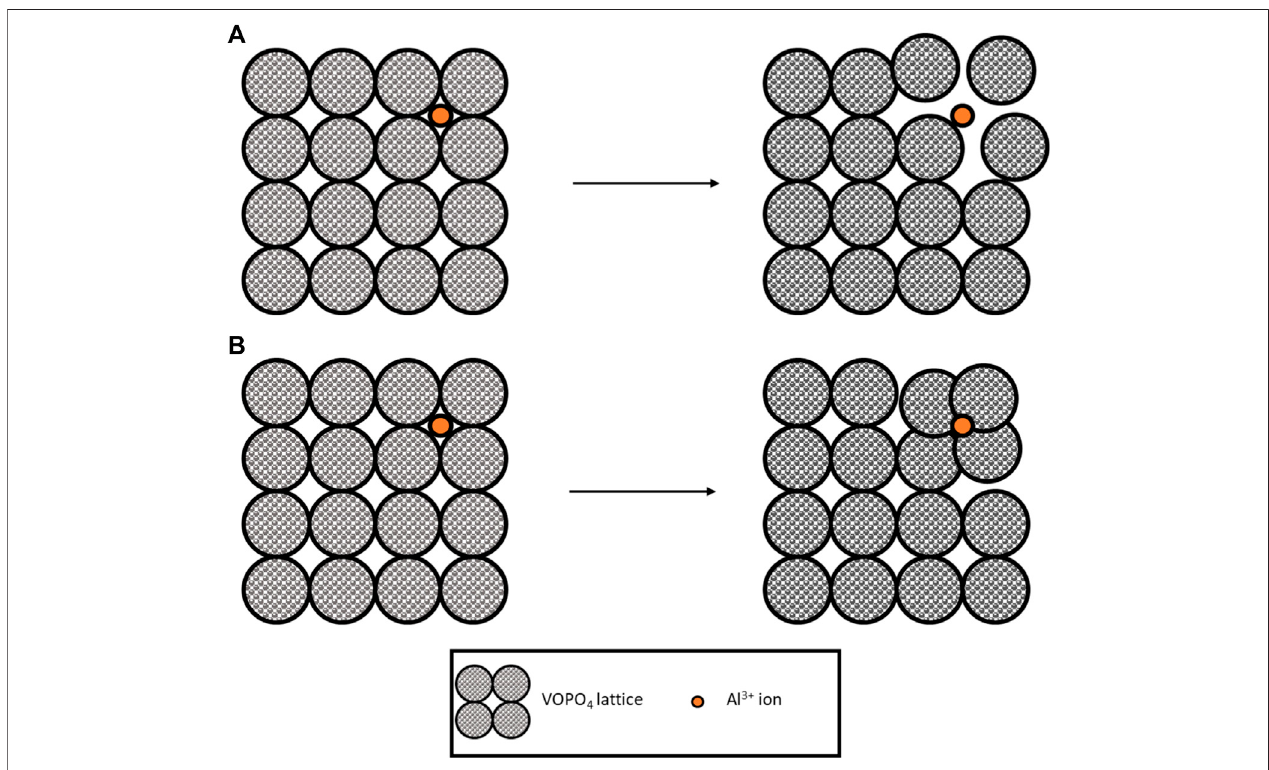
FIGURE 4 | Illustration of lattice accommodation to Al-ions, (A) lattice expanded, and (B) lattice attracted toward ions and contracting.